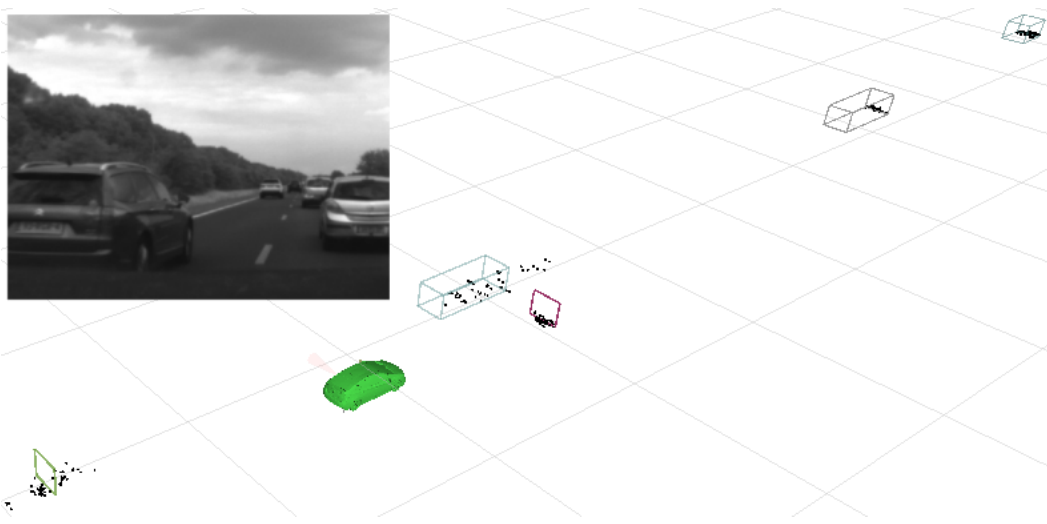
Figure 9. World model impression. Vehicles that have overtaken the host are associated with both kinematic and geometric information, whereas other vehicles have an unknown